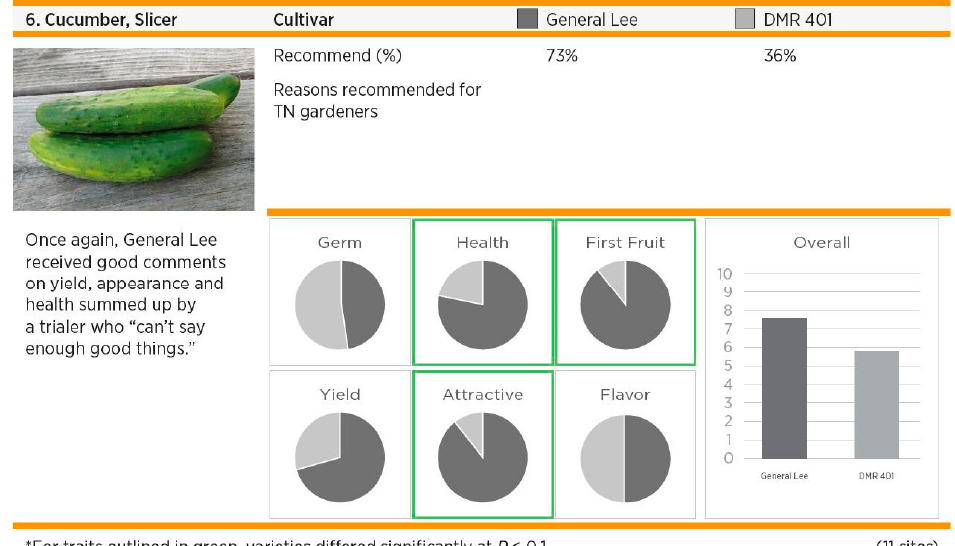
Figure 2. Example summary data for the slicer cucumber trial in the 2020 HGVT showing the results and statistical comparison of cultivars ‘General Lee’ and ‘DMR 401 (cid:48) trialed. Green boxes around the health, first fruit, and attractive fruit comparisons illustrate that ‘General Lee’ was rated as significantly higher ( p < 0.1) in those areas versus ‘DMR 401 (cid:48)